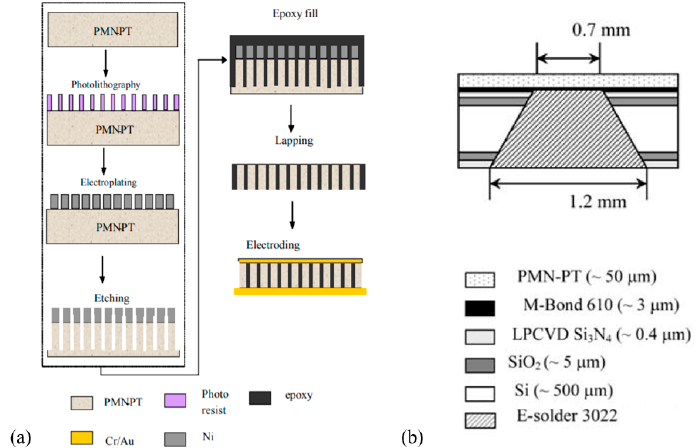
Figure 9. ( a ) Process flow for fabricating PMN-PT/epoxy 1-3 composite-based pMUT (Reproduced with permission from IEEE [98]). ( b ) Cross-view schematic of a PMN-PT single-crystal-based pMUT (Reproduced with permission from Springer Nature [100]).